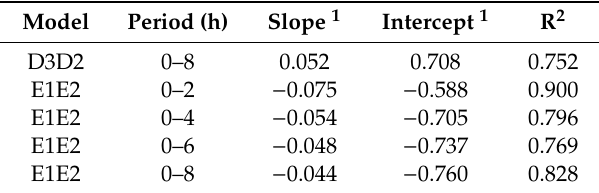
Table 6. Parameters of the combined linear regression models.